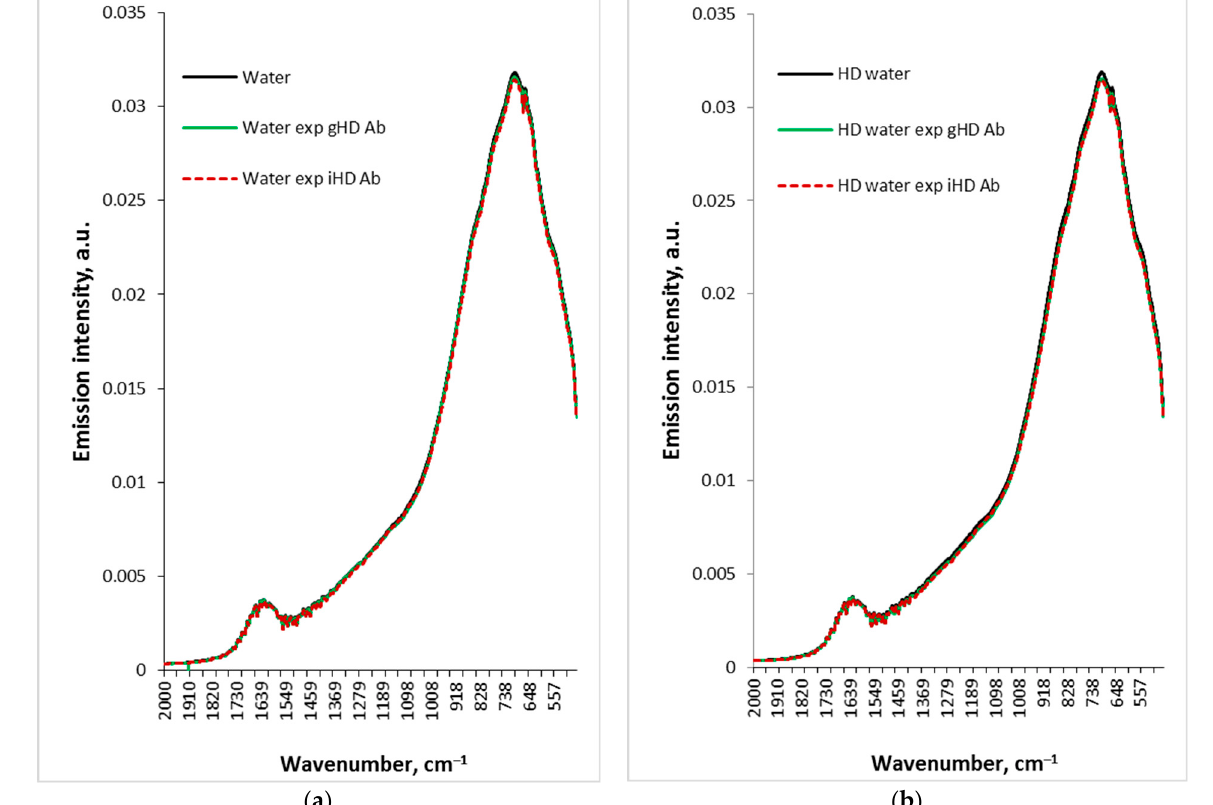
Figure 5. Emission spectra of samples (( a ) water, ( b ) HD water) before and after non-contact action of iHD Ab and gHD Ab in the range of 470–2000 cm − 1 . In sample labels, ‘exp’ means ‘ exposed to’.